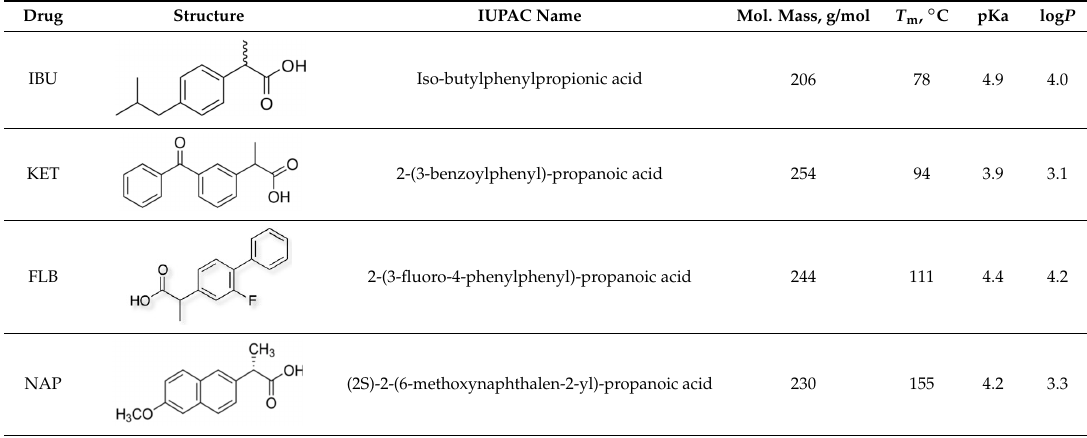
Table 1. Chemical structures and physical-chemical properties of the studied profens. Drug